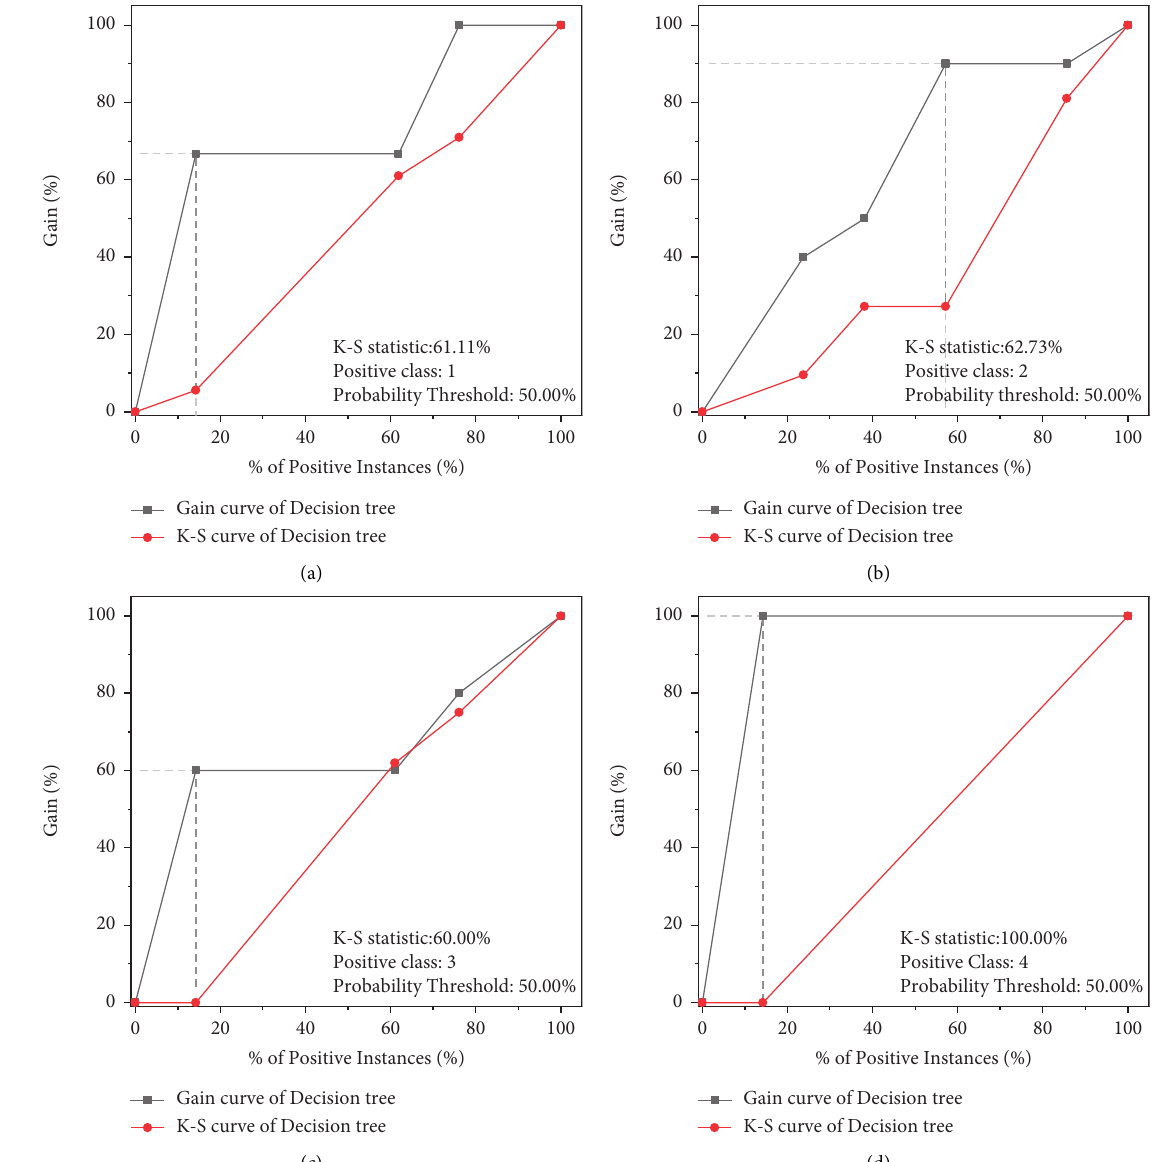
Figure 12: K-S and gain curve of each classification test of the decision tree